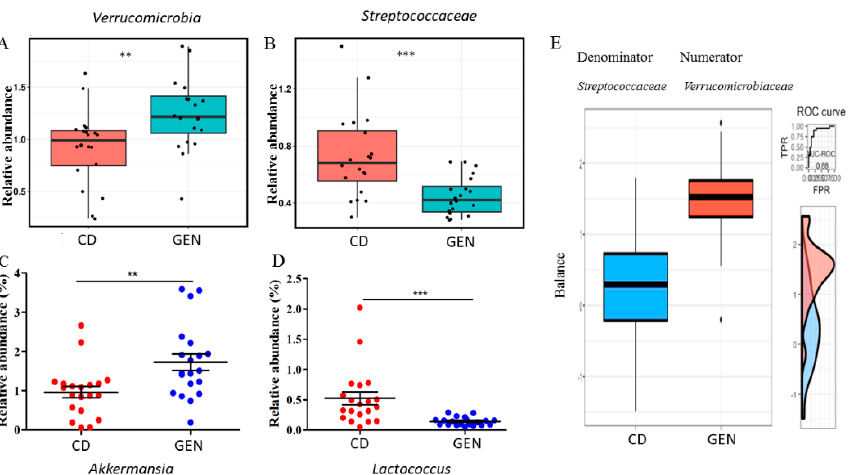
Figure 5. Genistein (GEN) supplementation affected the gut microbiome composition. ( A ) The phylum Verrucomicrobia , ( B ) the family Streptococcaceae , ( C ) Akkermansia , and ( D ) Lactococcus were significantly affected by adult GEN intake in the offspring regardless of their maternal dietary status. ( E ) A microbial signature selected by selbal with a strong predictive accuracy to distinguish the GEN supplementation status. The signature consisted of Verrucomicrobiaceae (Numerator) and Streptococcaceae (Denominator). The box plots represent the distribution of the balance values for each category. The right (vertical) panel of the figure represents the Receiver Operating Characteristics (ROC) curves with the Area under the ROC curve (AUC) values (top) and density curves (bottom) for each category. GEN: with the genistein supplementation; CD: without the supplementation. ** p < 0.01; *** p <